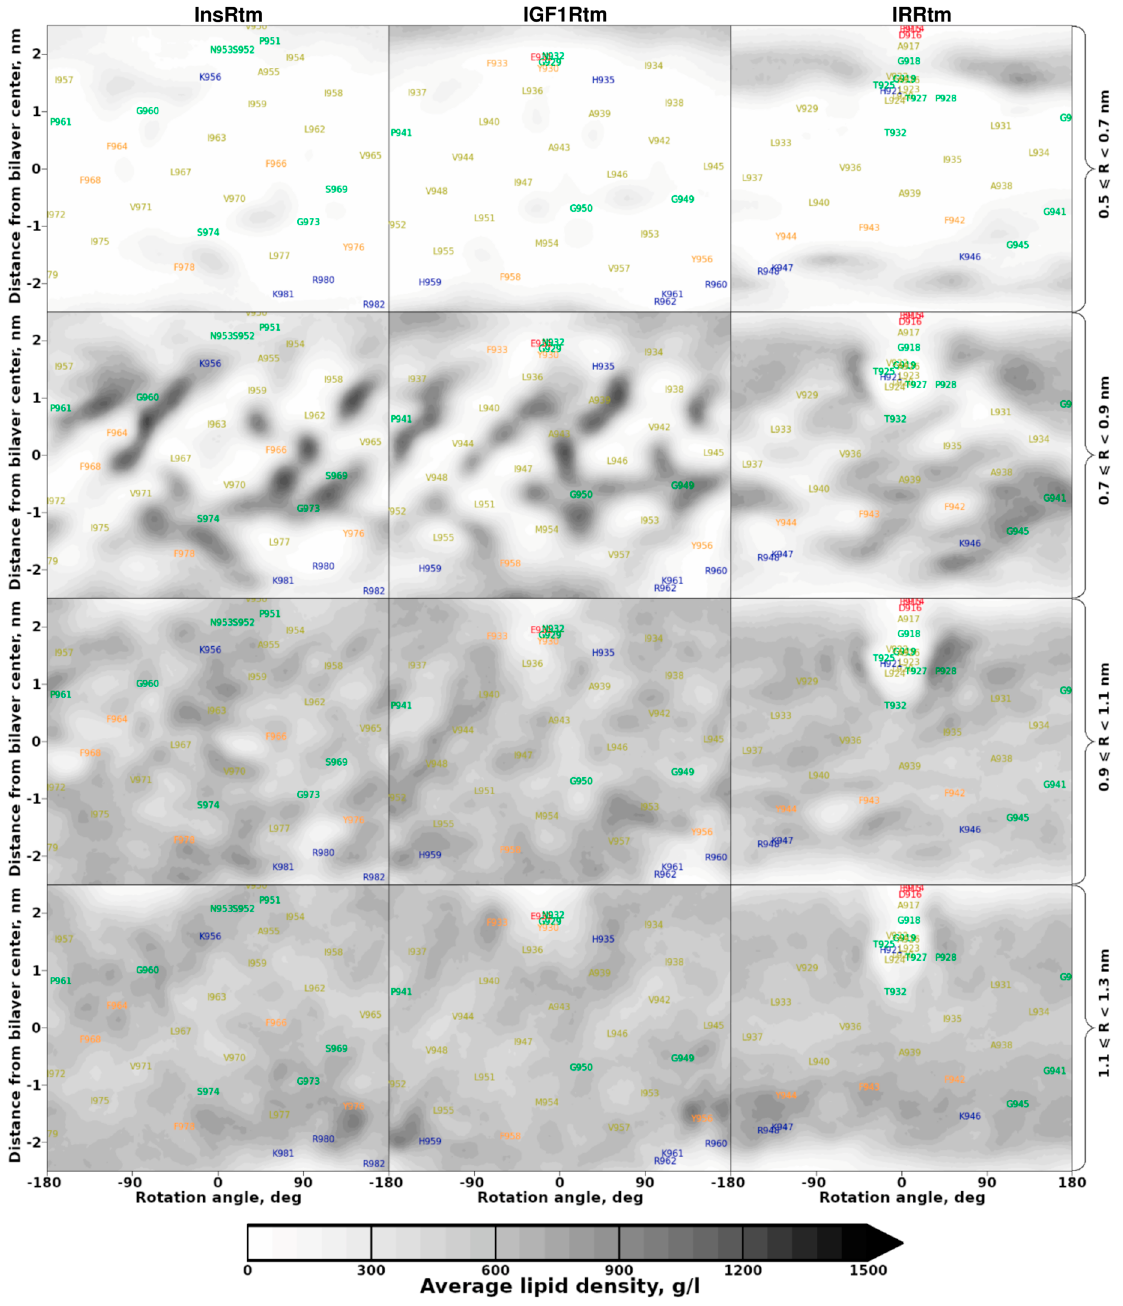
Figure 4. Lipid density distribution in cylindrical slices around the TMD helices. Lipid density was calculated in a cylindrical coordinate system with an axis corresponding to the TMD helix axis and averaged over MD trajectories in the POPC bilayer within the marked radius (R) range (in right). Darker areas represent larger average density values corresponding to immobilized lipids. Lower slices correspond to larger cylindrical slice radius.